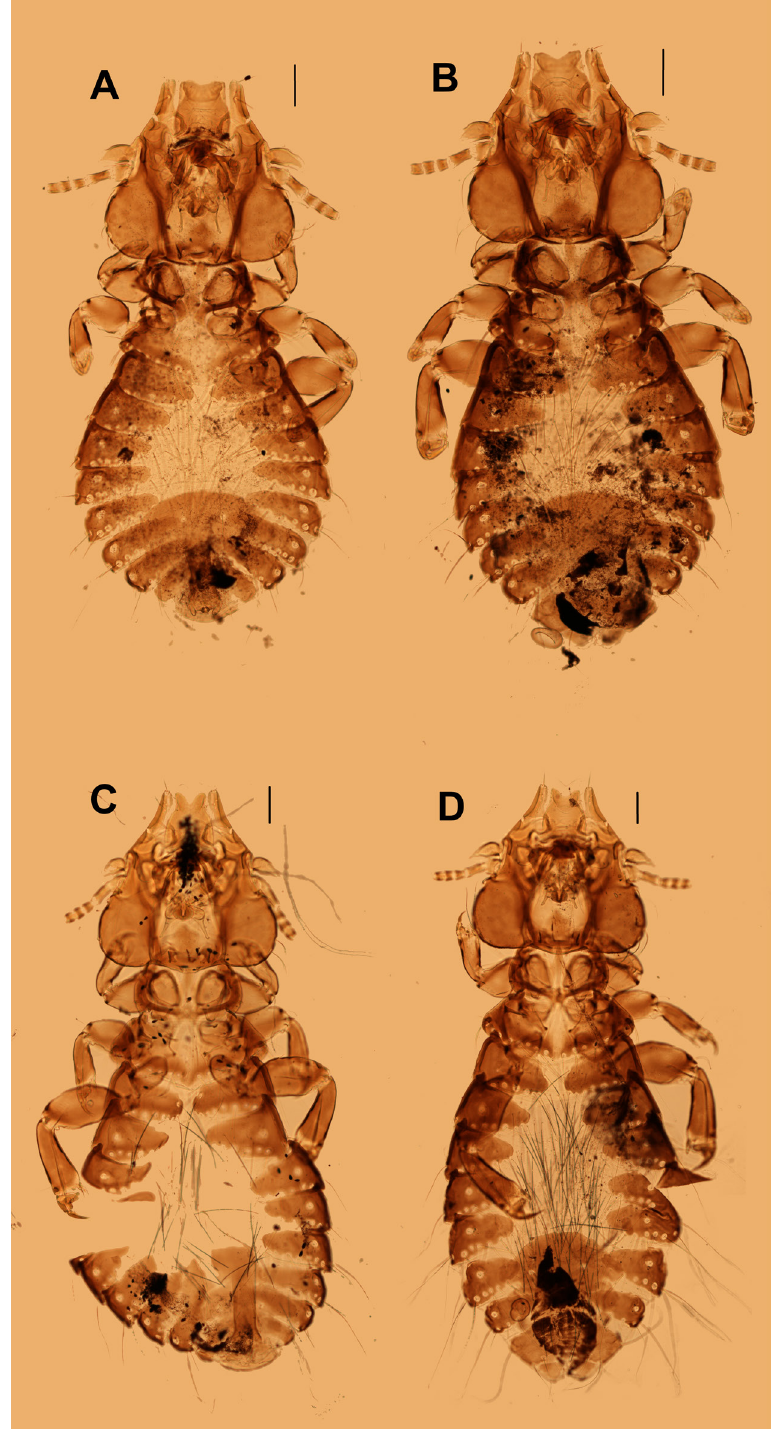
Fig. 8. A–B . Philopterus acrocephalus Carriker, 1949 ex Acrocephalus melanopogon : A . Herein described and illustrated male (MMBC SK25), dorsal view. B . Herein described and illustrated female (MMBC SK25), dorsal view. – C–D . Philopterus gustafssoni sp. nov. ex Regulus regulus : C . Holotype (MMBC CZ-OS01), dorsal view. D . Herein described and illustrated female paratype (MMBC CZ-OS01), dorsal view. Scale bars: 0.1